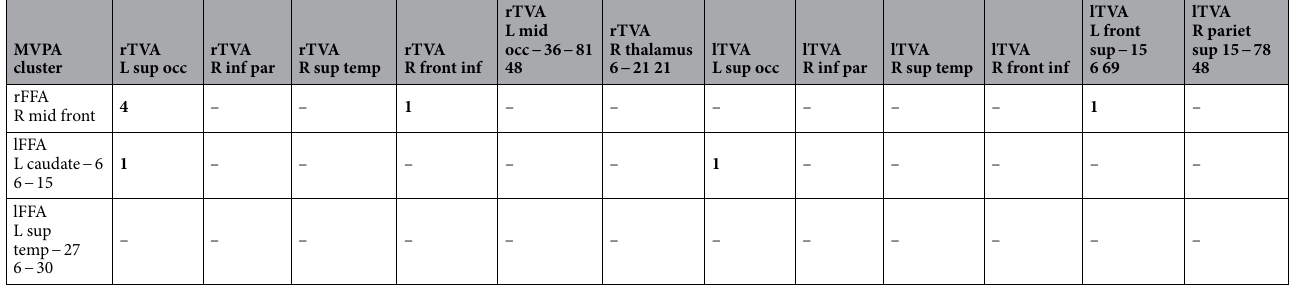
Table 5. Number of supramodal convergent RSFC clusters using MVPA clusters with the RSFC correlates of individual face-preferential responses in the right and left FFA with RSFC correlates of individual voice- preferential responses in the right and left TVA. Results are shown at a voxel-wise threshold of p < 0.001 and whole brain FWE-corrected at cluster level with a cluster threshold of p < 0.05. R right, L left. Supramodal conjunctions are encoded in bold. Voxel size 3 × 3 × 4 mm 3 .